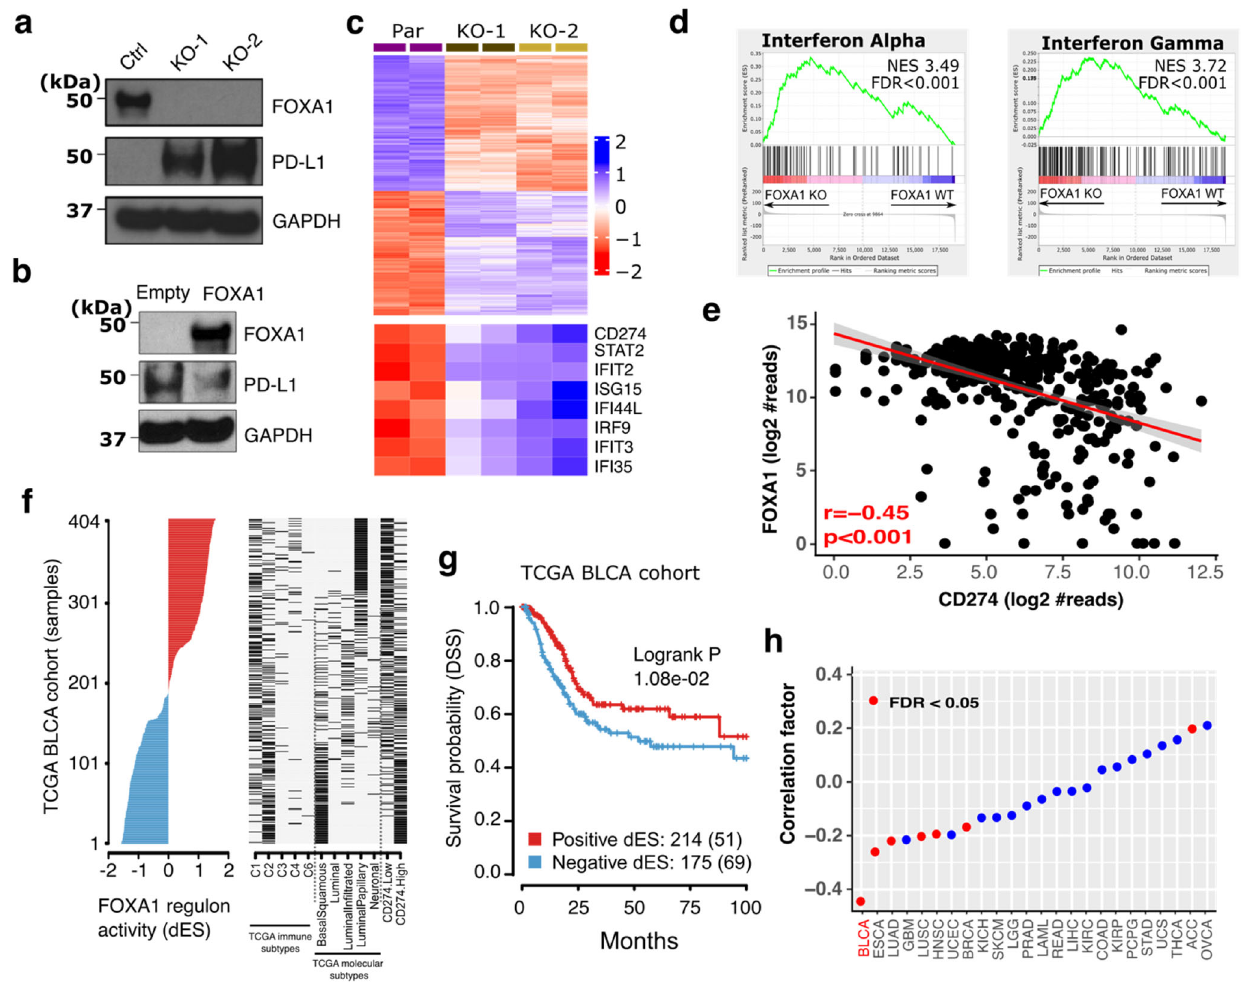
Fig. 5 | Genetic ablation of FOXA1 in bladder cancer cells results in increased expression of PD-L1 and interferon sensitive genes (ISGs). a CRISPR-Cas9 gene editing was used to generate isogenic UM-UC-1 bladder cancer cells with loss of FOXA1expression.ImmunoblotanalysisshowingthatlossofFOXA1expressionwas associated with increased PD-L1 expression. This analysis was performed in tripli- cate. Source data are provided as a Source Data fi le. b UM-UC-3 cells were trans- fectedwithFOXA1orwithemptyvector.Immunoblotanalysiswasthenperformed to quantitate expression of FOXA1, PD-L1, and GAPDH as a loading control. This analysiswasperformedintriplicate. c Differentialgeneexpression(FDR q <0.05)in parental and FOXA1-KO UM-UC-1 bladder cancer cells. Loss of FOXA1 expression wasassociated with upregulation of 1358genesincluding CD274(PD-L1) and other interferon response genes, and downregulation of 2187 genes. d Gene set enrich- ment analysis (GSEA) identi fi ed the interferon alpha and gamma pathways as the